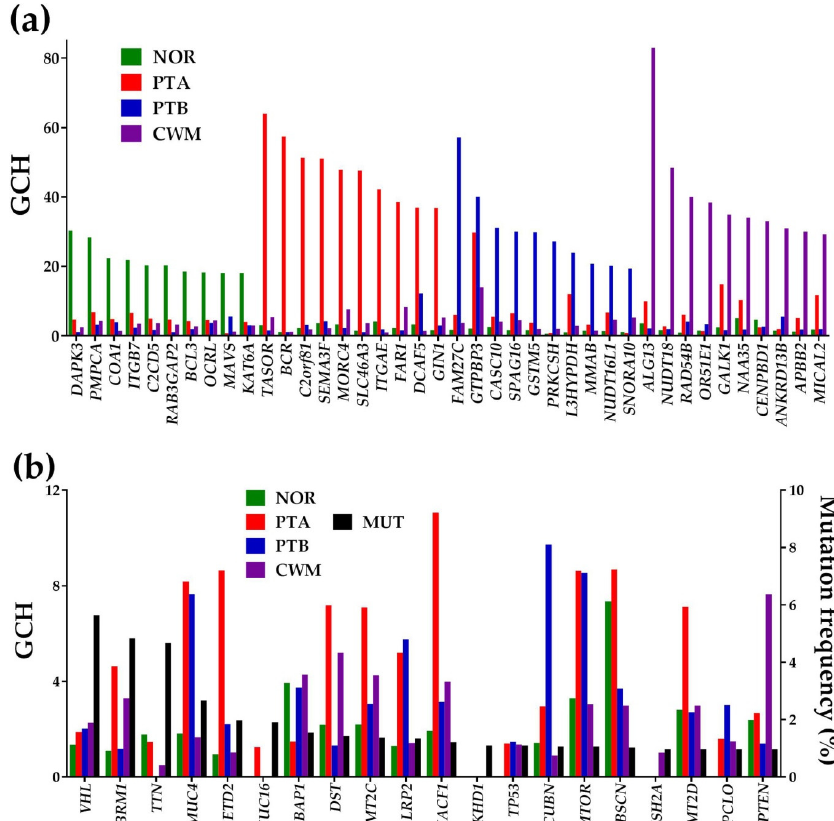
Figure 6. Gene commanding height (GCH) scores of some remarkable genes in each profiled region. ( a ) Top 10 genes in each region and their GCH scores in the other regions. ( b ) GCH scores of the most frequently mutated genes in kidney cancer (mutation frequency on the right axis). Missing columns in ( b ) indicate genes not adequately quantified in that region. GMRs: DAPK3 (death-associated protein kinase 3) from chromosome 19 in NOR, TASOR (transcription activation suppressor) from chromosome 3 in PTA, FAM27C (family with sequence similarity 27, member C, long non-coding RNA) from chromosome 9 in PTB, and ALG13 (UDP-N-acetylglucosaminyltransferase subunit) from chromosome X in CWM. Right axis in ( b ) shows the mutation frequency in the 3295 kidney cancer (KC) cases reported in [10].